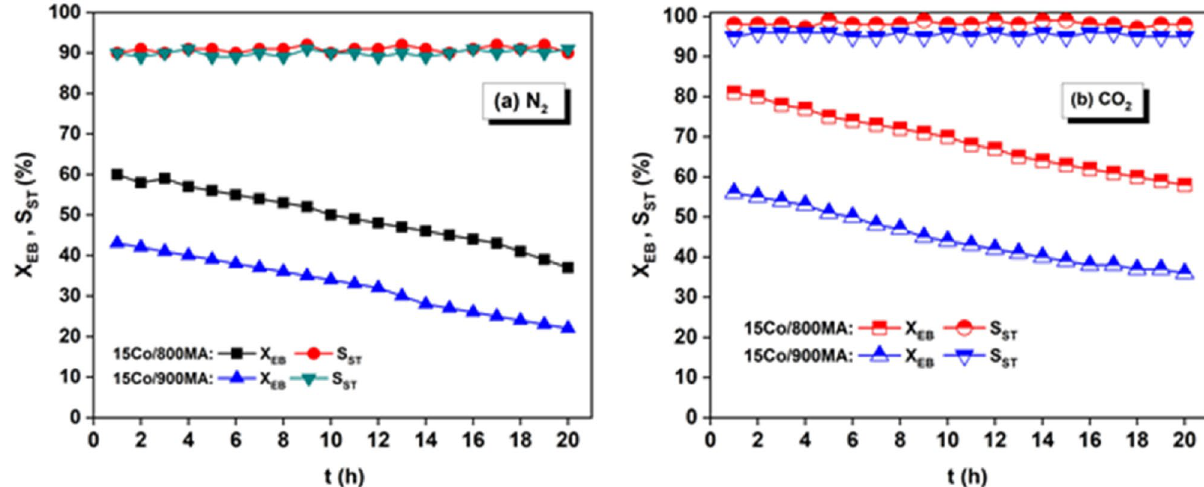
Figure 7. TOS on 15Co/800MA and 15Co/900MA catalysts under ( a ) N 2 flow, ( b ) CO 2 flow ( a ) N 2 flow, ( b )